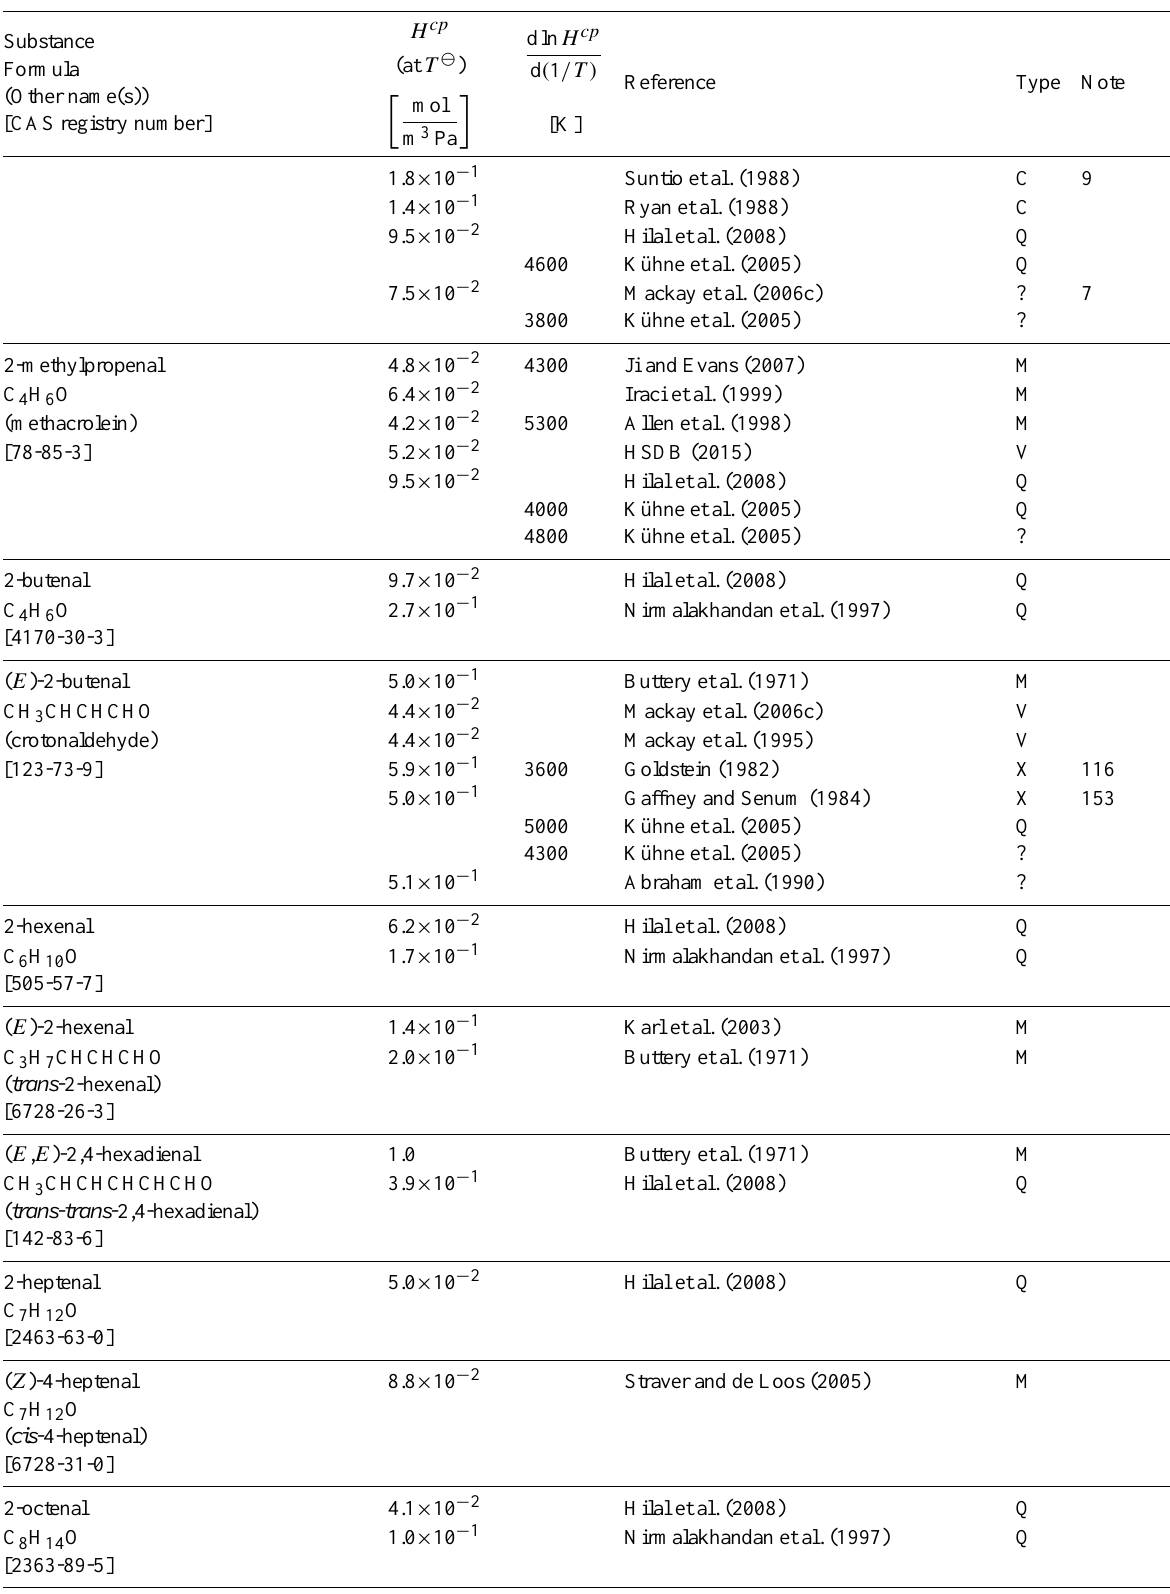
Table 6: Henry’s law constants for water as solvent